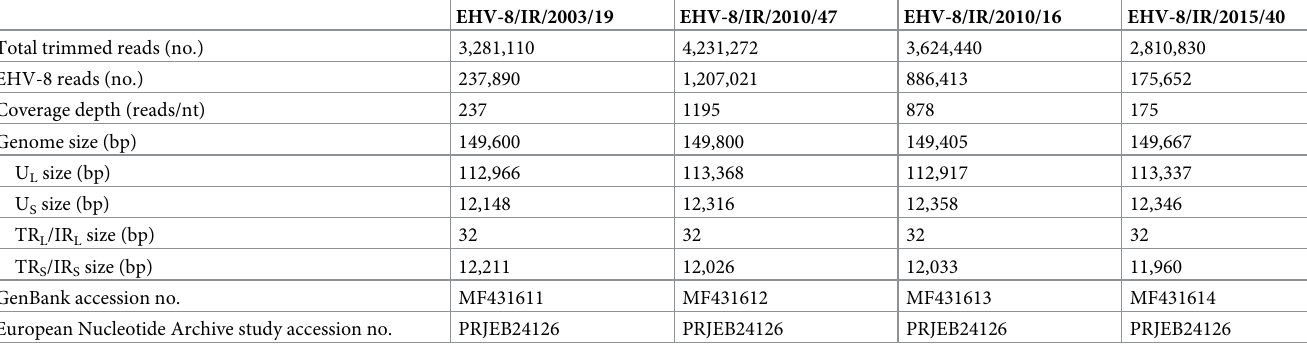
Table 1. Summary of sequencing and genome data for the four Irish EHV-8